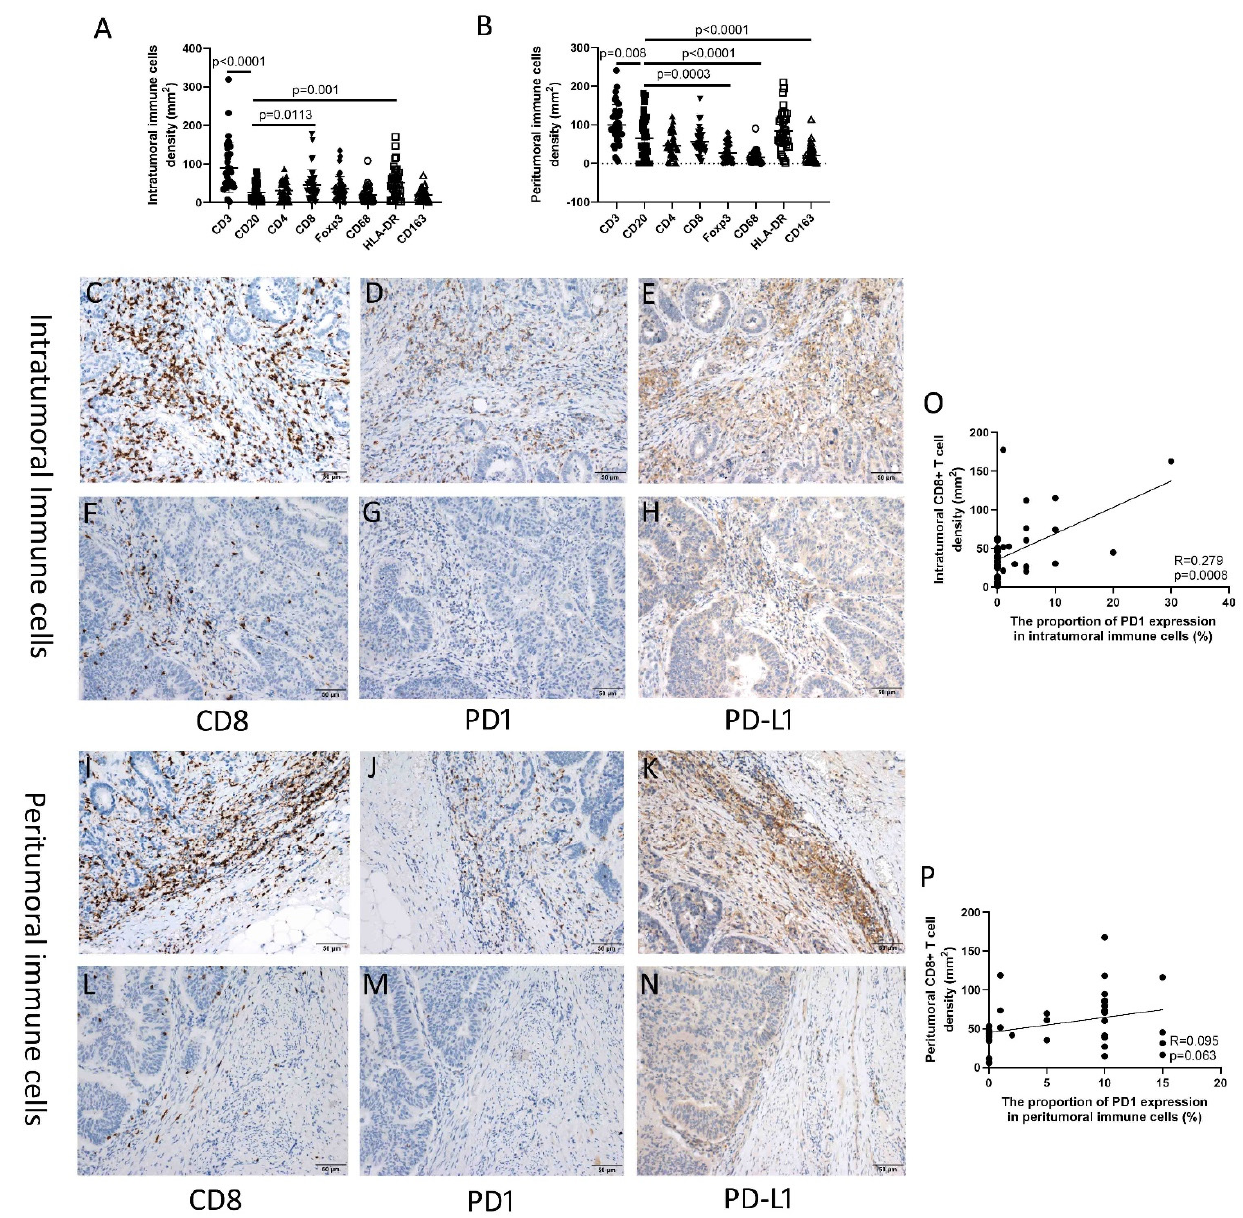
Figure 1. Immune microenvironment of UrC. ( A ) The number of intratumoral immune cells. ( B ) The number of intratumoral immune cells. ( C – E ) Relative high density or proportion of CD8, PD1, and PD-L1 expression on immune cells in intratumoral stroma. ( F – H ) Relative low density or proportion of CD8, PD1, and PD-L1 expression on immune cells in intratumoral stroma. ( I – K ) Relative high density or proportion of CD8, PD1, and PD-L1 expression on immune cells in peritumoral stroma. ( L – N ) Relative low density or proportion of CD8, PD1, and PD-L1 expression on immune cells in peritumoral stroma; ( O , P ) The association of CD8+ cell density and proportion of PD1 expression on immune cells in intratumoral ( O ) and peritumoral stroma ( P ). In the peritumoral immune cells, the median density of CD3+ T cells was